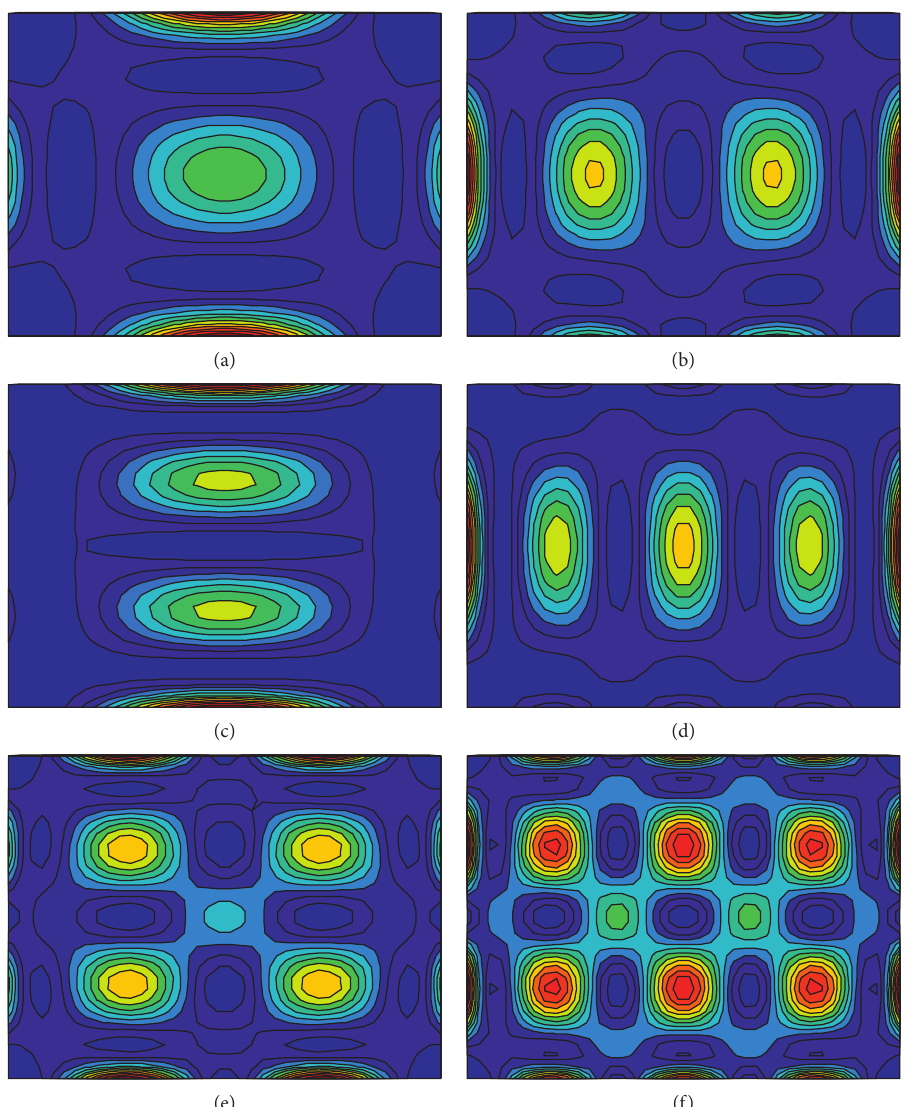
Figure 16: Strain energy contours for the first 6 modals: (a) 1st modal, (b) 2nd modal, (c) 3rd modal, (d) 4th modal, (e) 5th modal, and (f) 6th